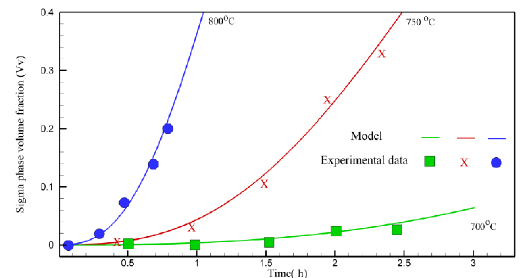
Figure 11. Model predictions confronted with experimental predictions of sigma phase under favorable formation conditions.